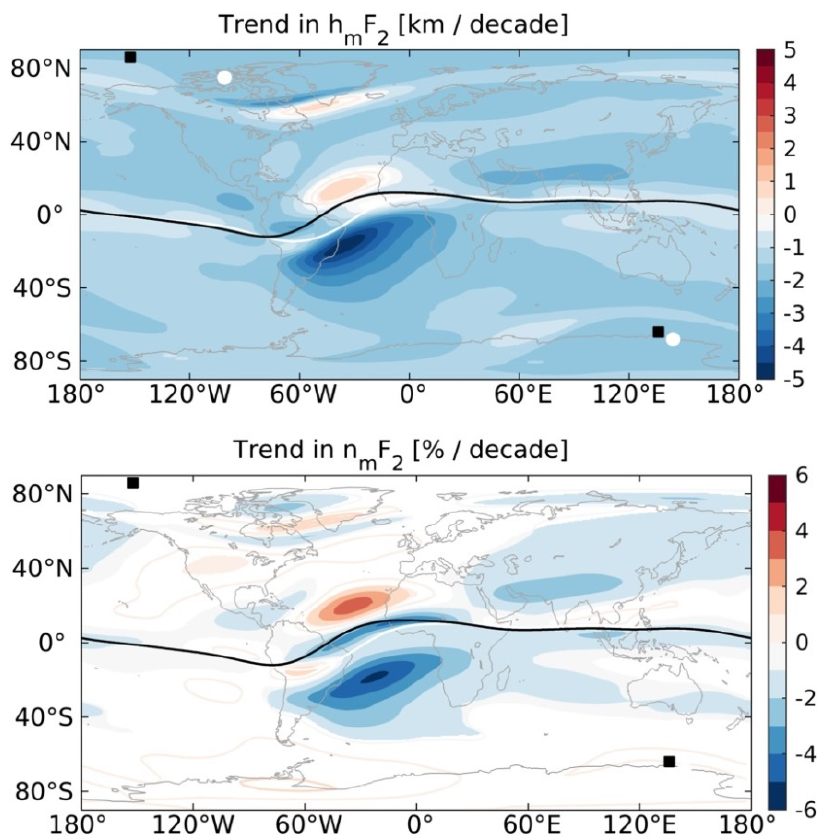
Figure 2. WACCM-X model simulations of trends in hmF2 (top panel) and NmF2 (bottom panel) over 1950–2015. Positions of magnetic poles and equator are shown in white for 1950 and black for 2015. After [31].